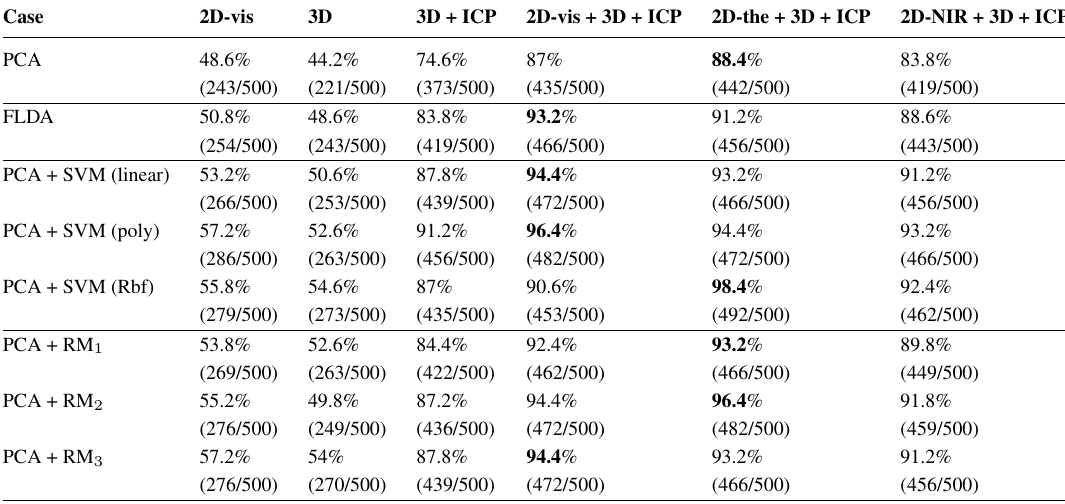
Table 1. Recognition rate with respect to pose variation. ICP, iterative closest points; PCA, principal component analysis; FLDA, Fisher linear discriminant analysis; SVM, support vector